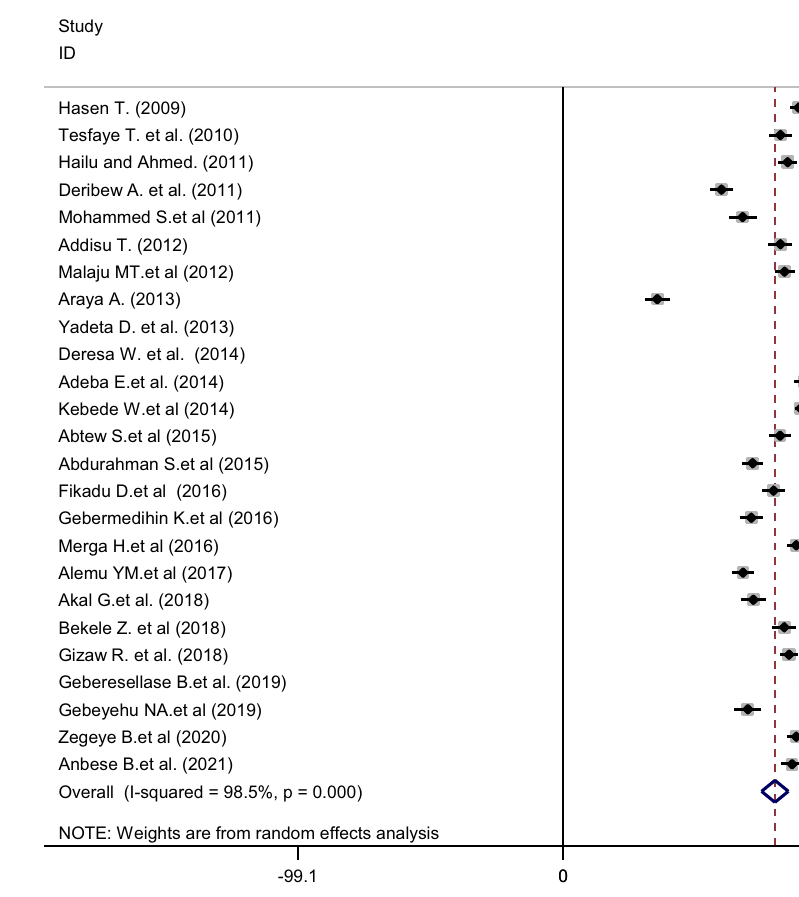
Fig. 2 Forest plot showing pooled utilization of provider-initiated HIV testing and counselling in